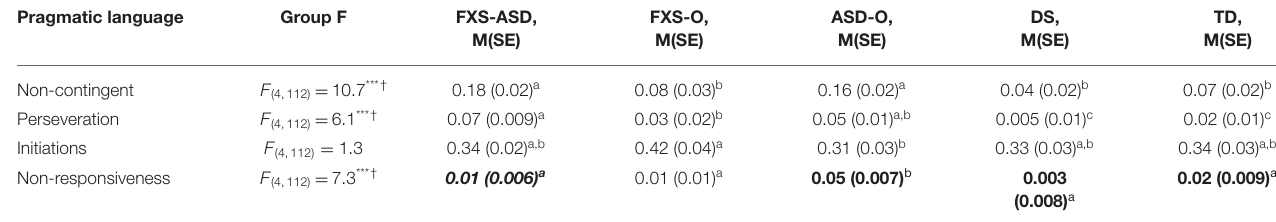
TABLE 3.1 | Group differences in pragmatic language in males. Structured